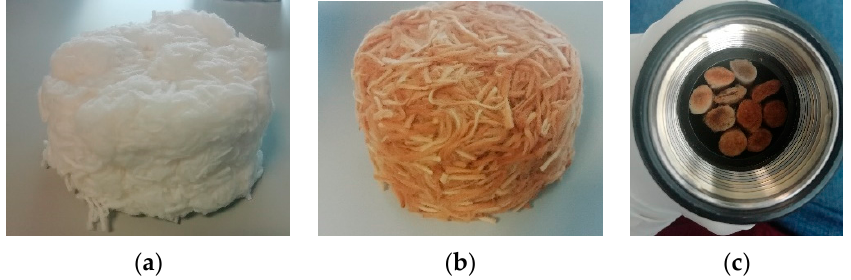
Figure 1. Example pictures of some of the prepared samples: ( a ) sample from disaggregated non-used cigarette butts; ( b ) sample from disaggregated used cigarette butts; ( c ) sample from used cigarette butts before the cleaning treatment .